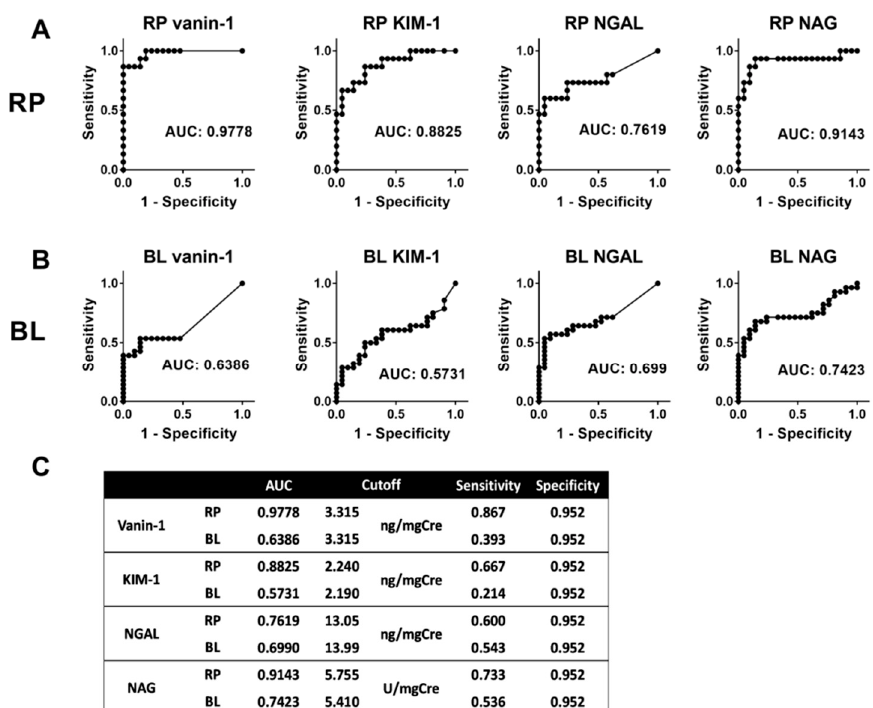
Figure 3. ROC curve analysis for each AKI biomarker. The area under the curve (AUC) of the receiver operating characteristics (ROC) curve analysis for each AKI biomarker in renal pelvic ( A ) and bladder urine ( B ) are shown. AUC, cutoff, sensitivity, and specificity in each AKI biomarker are shown in Table ( C ). RP, renal pelvis; BL, bladder; AUC, area under curve.